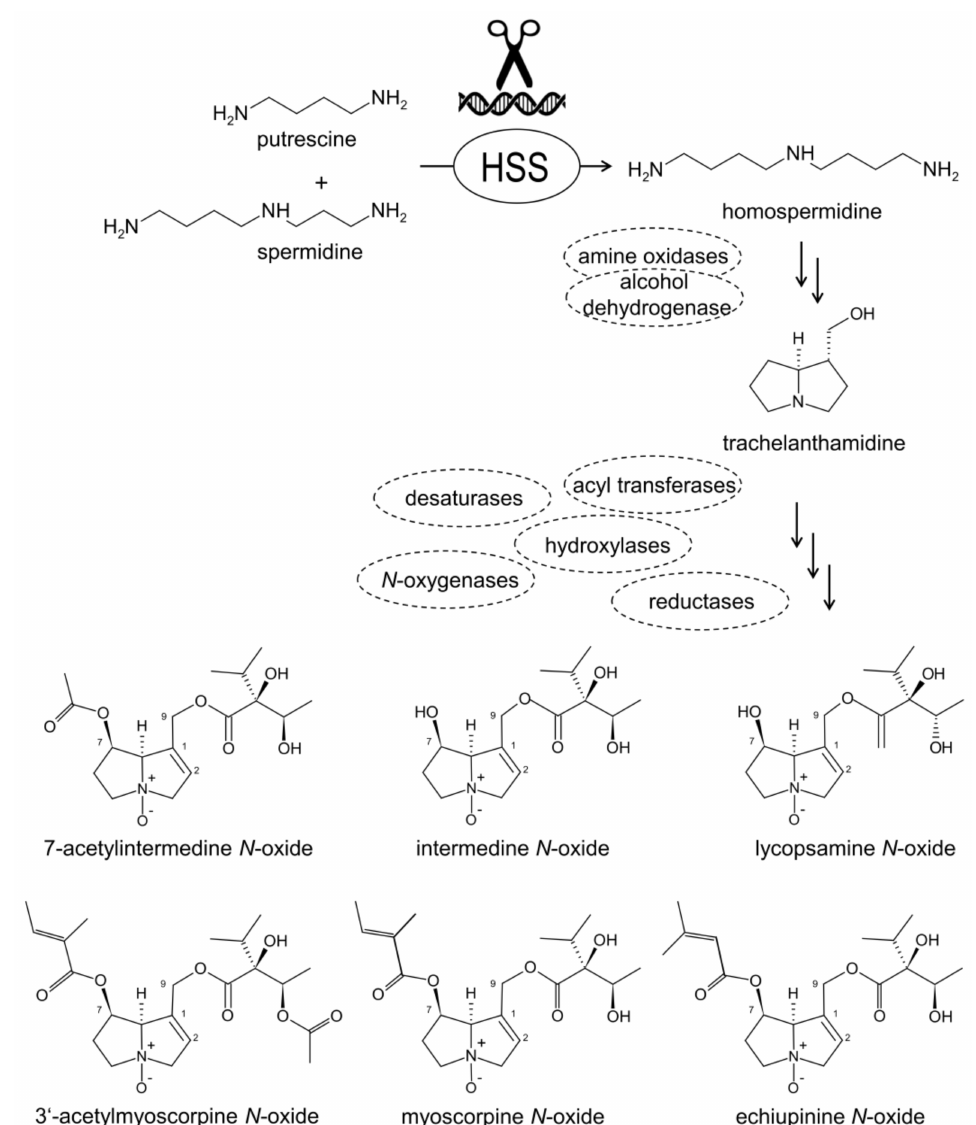
Figure 1. Pyrrolizidine alkaloid (PA) biosynthesis. Homospermidine synthase (HSS) catalyzes the formation of homosper- midine as the exclusive substrate for PAs. Further enzymes are postulated (labeled by dashed ovals), but the sequence of enzymatic conversions is not known. Structures of the intermediate trachelanthamidine and of six PAs characteristic for hairy roots (HRs) of S. officinale are shown in their N -oxide